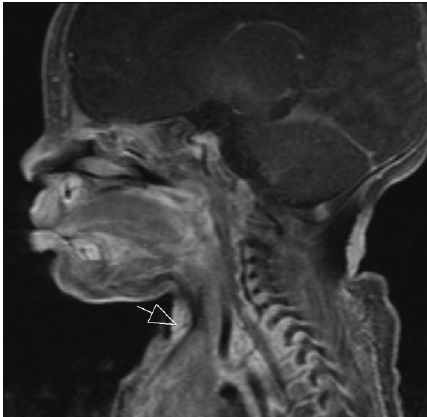
Figure 4: Sagittal T1, postgadolinium image shows small cervical tract (arrow) which terminates within the soft tissues and with no extension into deeper structures of the